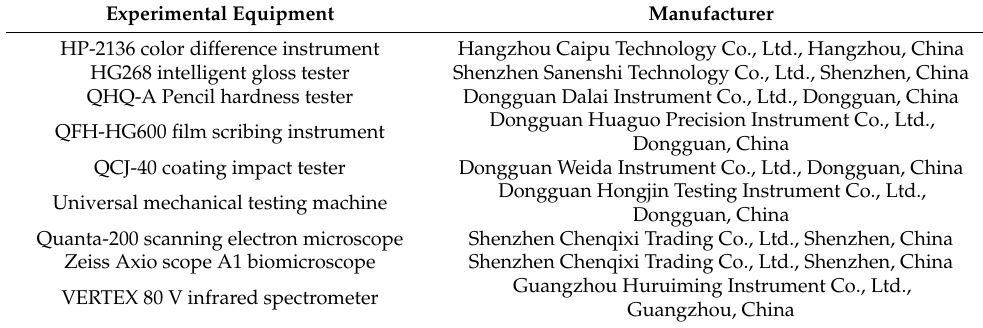
Table 5. Experimental equipment list.